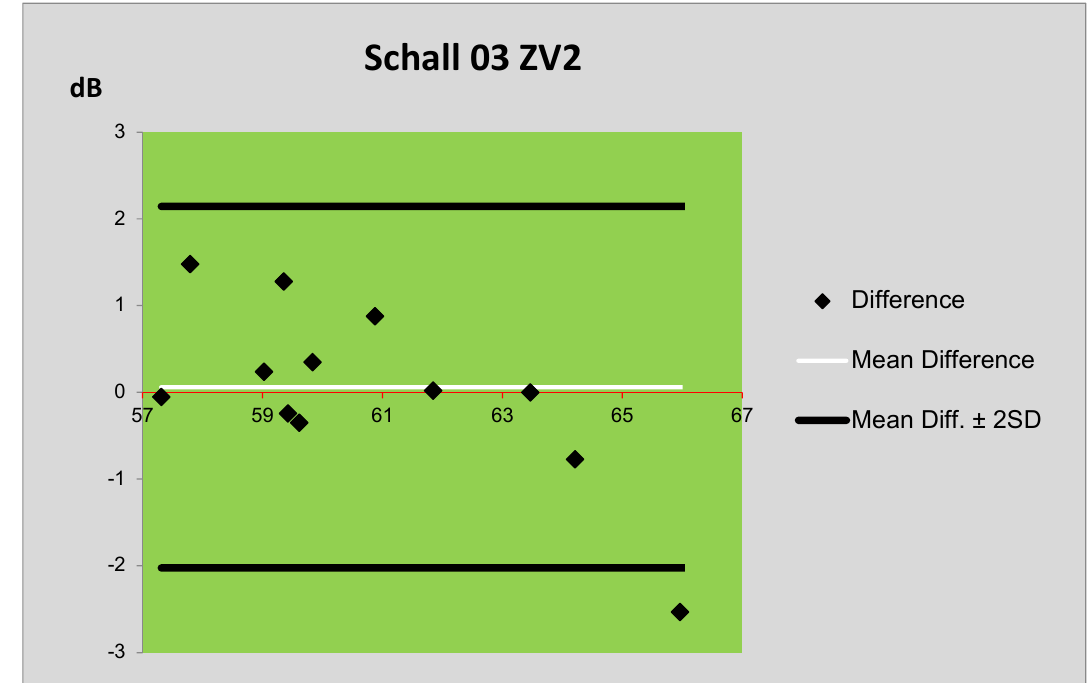
Figure 8. Bland–Altman plot of di ff erences between the prediction (Schall 03) and measurement of ZV2.